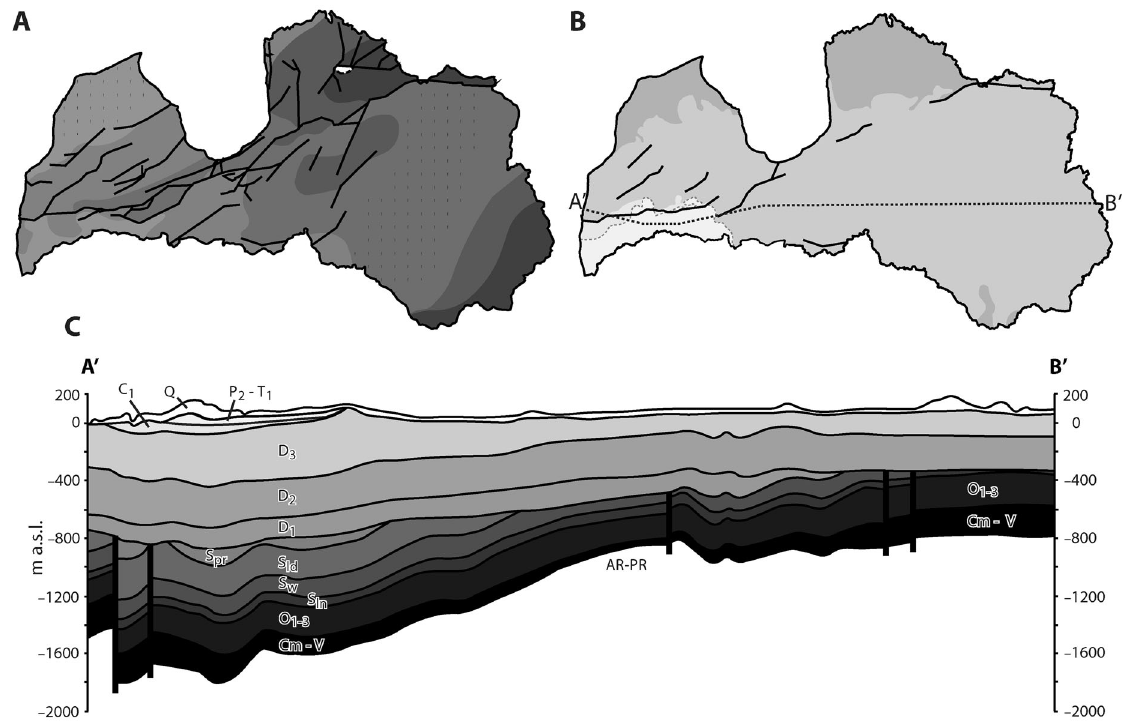
Fig. 3. Geological and structural characterization of Latvia (modified after Brangulis & Ka ņ evs 2002). A , simplified geological map of the Caledonian structural complex; B , simplified geological map of the Hercynian structural complex; C , simplified geological cross section. Thick lines denote major faults. The dotted area in A shows the lower Devonian Gargzdu series; location of the cross section is indicated by a dashed line in B. AR–PR, Precambrian crystalline basement; Cm–V, Cambrian–Ediacaran sequence; O 1–3 , Ordovician sequence; S ln , Silurian, Llandovery; S w , Silurian, Wenlock; S ld , Silurian, Ludlow; S pr , Silurian, Pridoli; D 1 , Lower Devonian; D 2 , Middle Devonian; D 3 , Upper Devonian; C 1 , Carboniferous; P 2 –T 1 , Permian–Triassic sequence; Q,